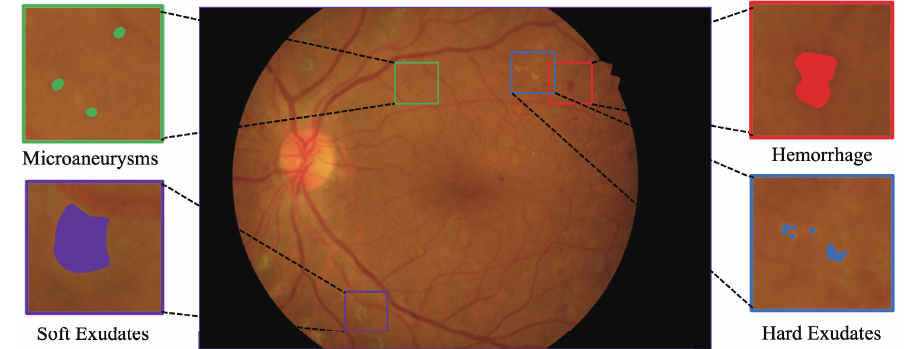
Figure 1. Illustration of fundus image with DR